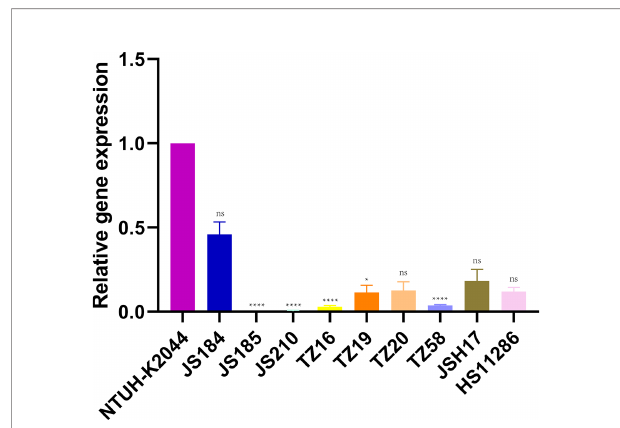
FIGURE 7 | Expression of galF among 35 putative bla KPC (+)-HvKP and Hv- bla KPC (+)-KP strains. Klebsiella pneumoniae NTUH-K2044 was used as the standard to which others were compared. Kruskal-Wallis test was used for comparison. bla KPC , beta-lactamase K. pneumoniae carbapenemase gene; bla KPC (+)-HvKP, bla KPC (+) hypervirulent K. pneumoniae ; Hv- bla KPC (+)-KP, hypervirulent bla KPC (+) K. pneumoniae ; ns, not signi fi cant; ****, p < 0.0001; *, p <